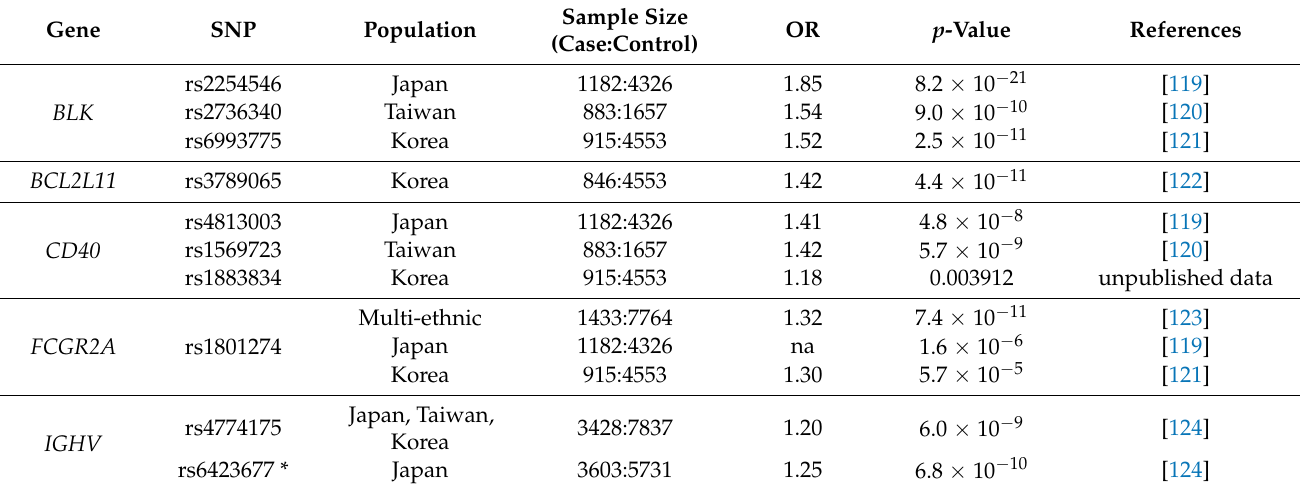
Table 4. KD susceptibility genes with genome-wide significance, as identified by GWAS ( p < 5 × 10 − 8 ).